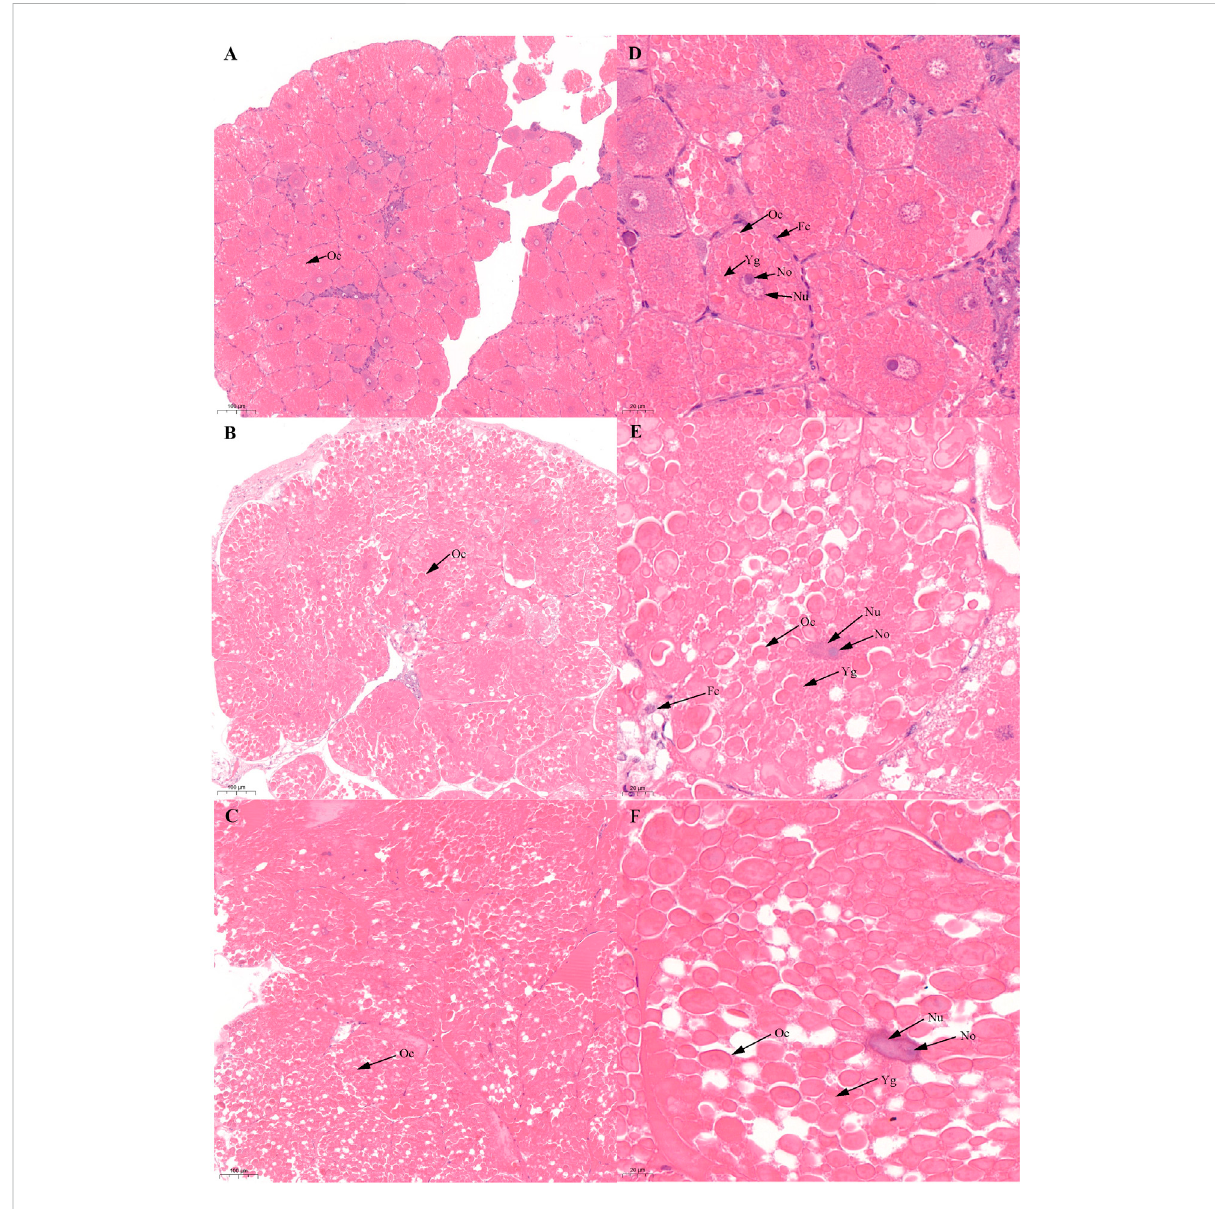
FIGURE 1 Histological characteristics in the ovary of Scylla paramamosain during the FVP. (A,D) : ovarian stage Ⅲ (F-OV-3); (B,E) : ovarian stage Ⅳ (F-OV-4); (C,F) : ovarian stage Ⅴ (F-OV-5). Oc, Oocyte; Fc, Follicular cells; Nu, Nucleus; No, Nucleolus; Yg, Yolk